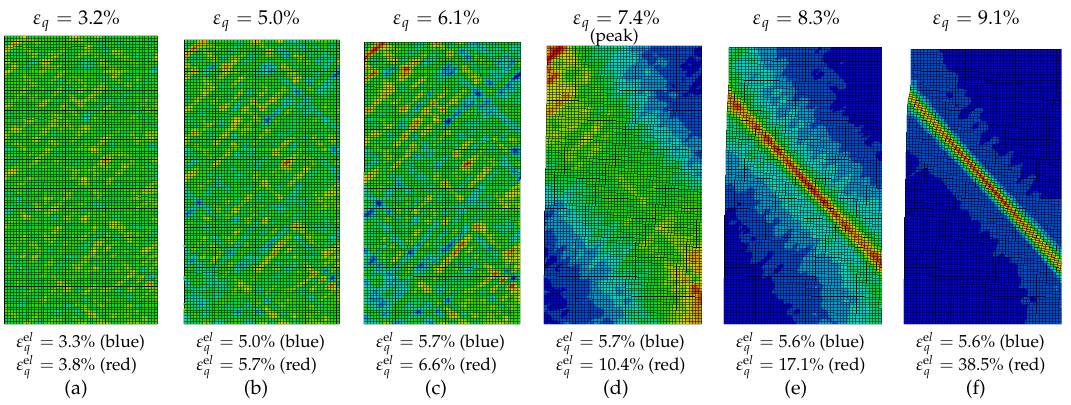
Figure 7. OCR = 3: Shear band development displayed with deviatoric strain in each element ε el q at different global deviatoric strain ε q , peak in q is at ε q = 7.4%. ( a – c ) show pre-peak pattern of shear bands, ( d ) peak and ( e , f ) post-peak pattern of shear